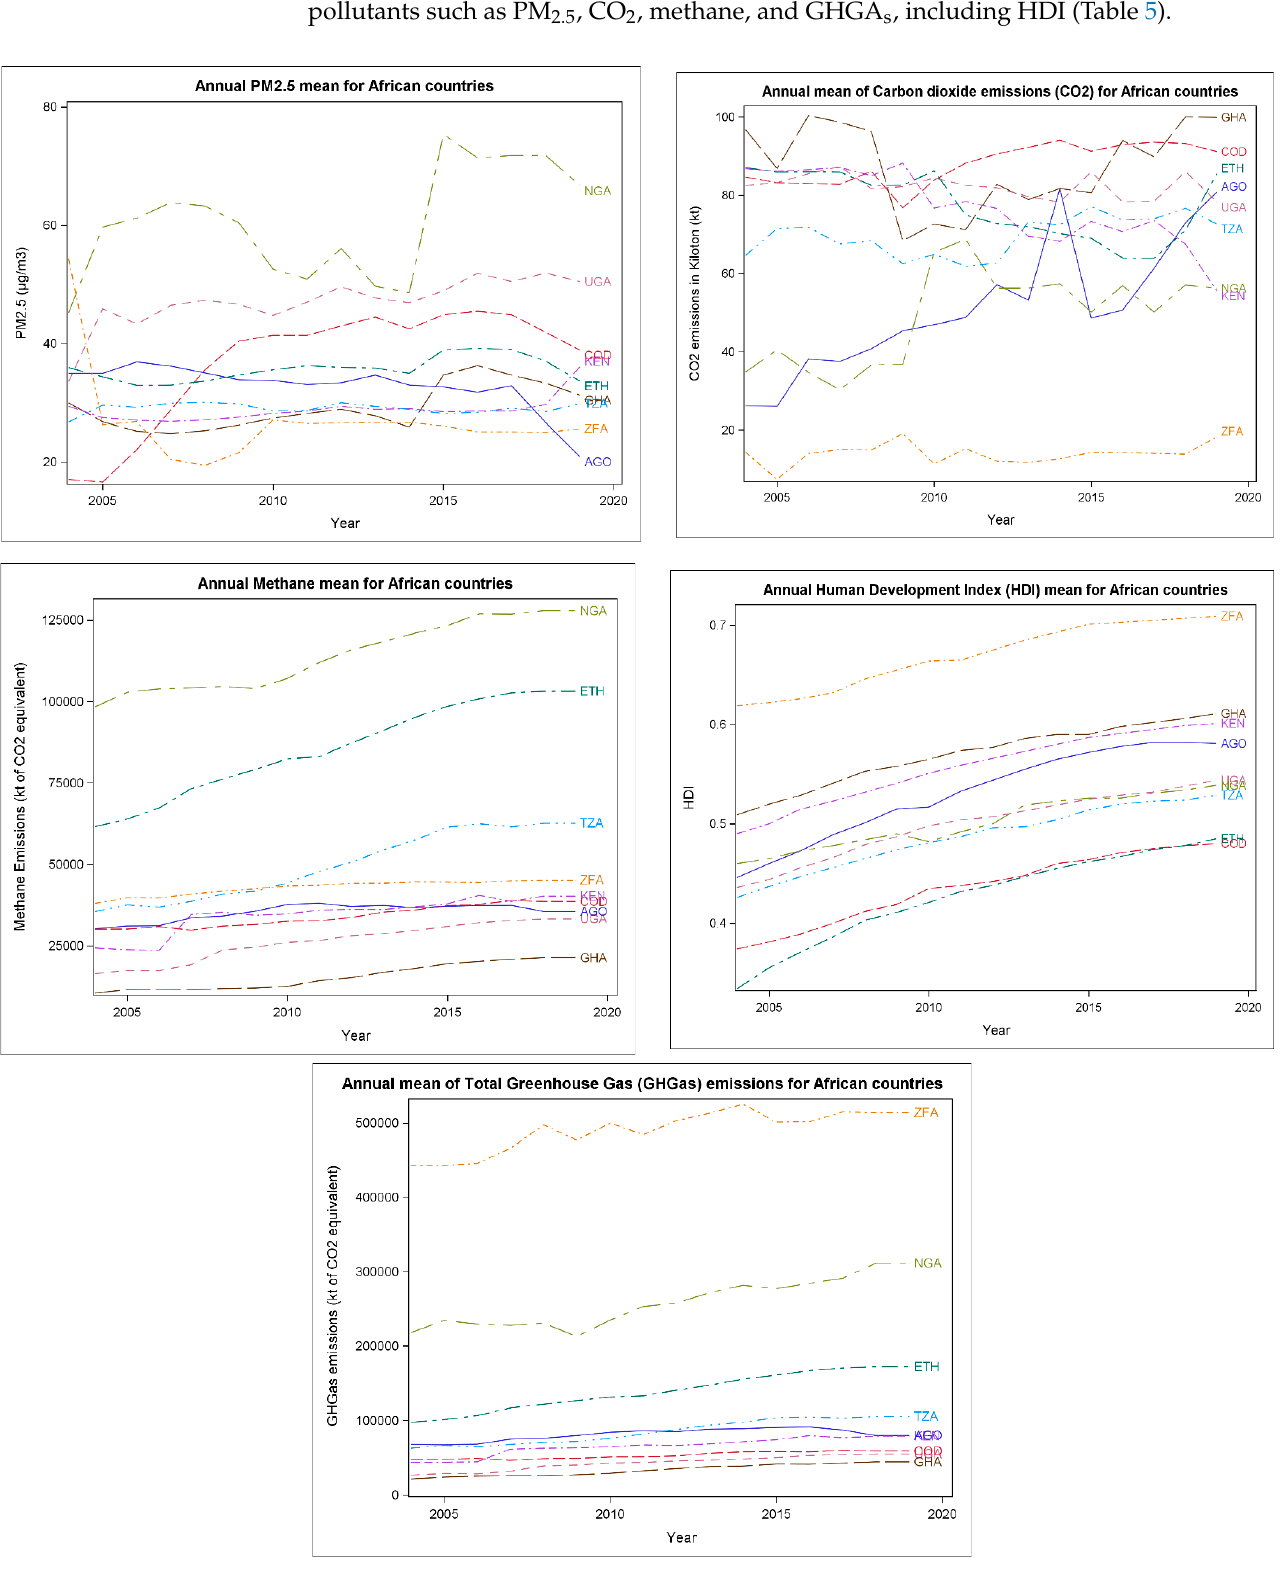
Figure 4. Annual pollutants levels plotted by country during 2005–2020.